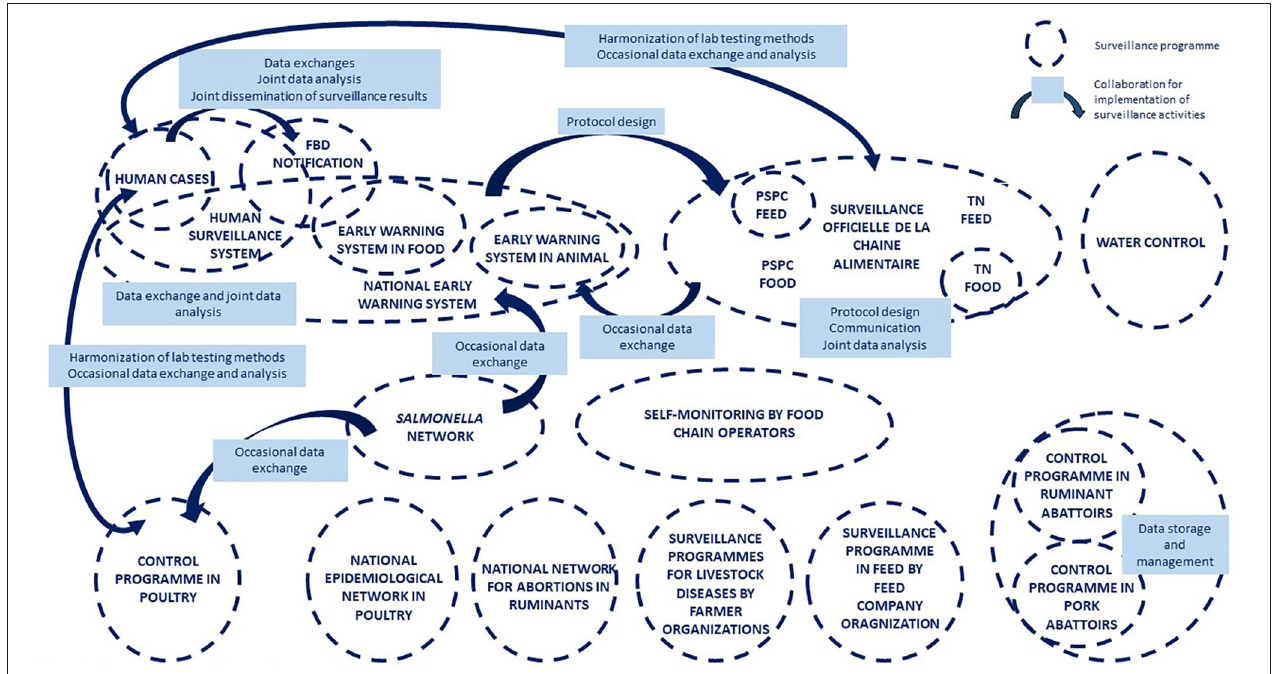
FIGURE 8 | The System map of the surveillance of Salmonella in